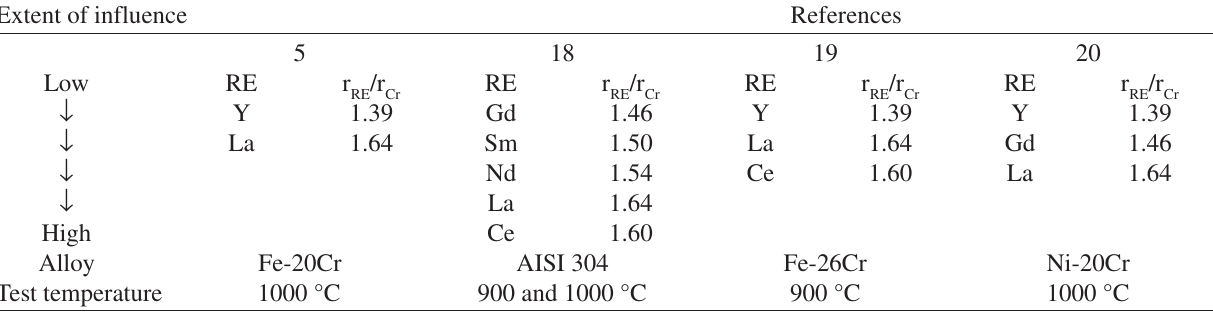
Table 2. Listing of RE elements in order of increasing influence on oxidation of chromia forming alloys. Data extracted from references /r - ratio of ionic radii of RE element and mentioned. r RE Cr